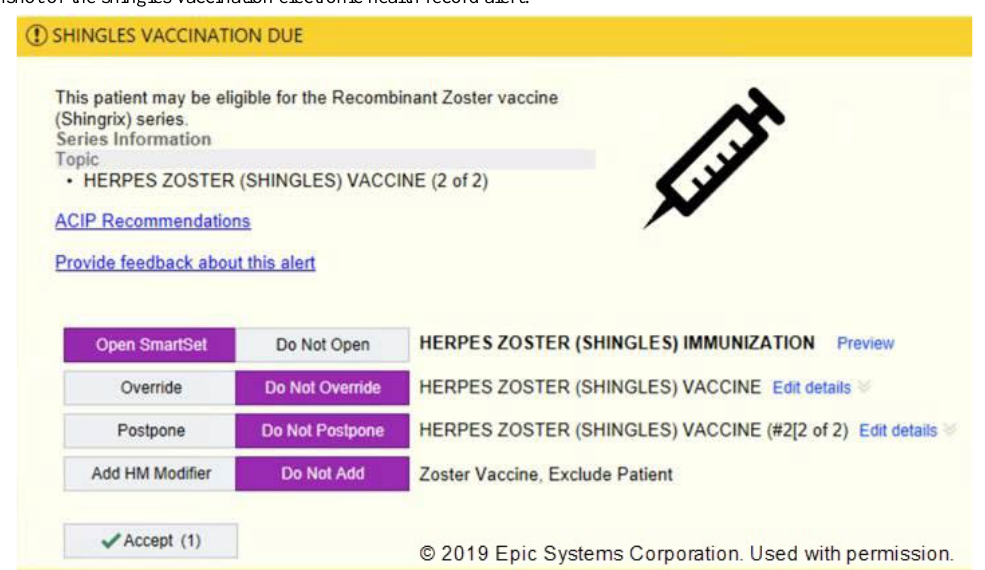
Figure 1. Screenshot of the shingles vaccination electronic health record